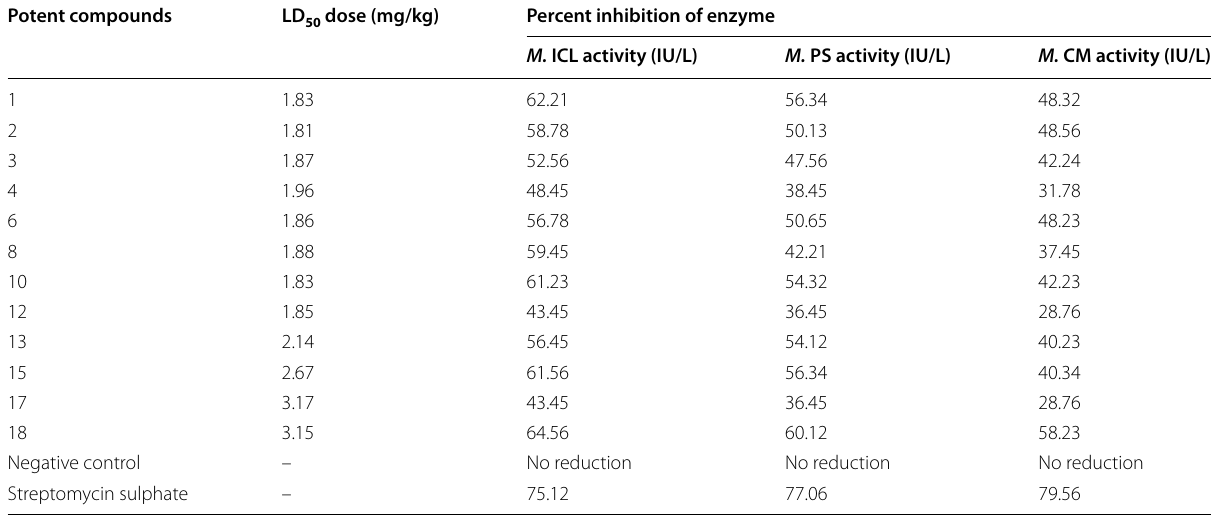
Table 4 Lethal dose (in mg/kg) and percent inhibition of enzymes in Mycobacterium H37Rv groups after treatment with effective dose of 1.34 mg/kg of potent compounds and 25 µg/kg of positive control Potent compounds LD 50 dose (mg/kg) Percent inhibition of